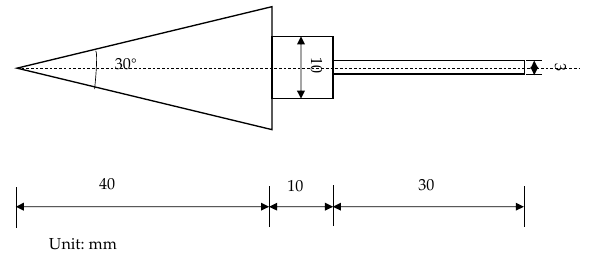
Figure 1. Dimensions of the CPT cone needle.